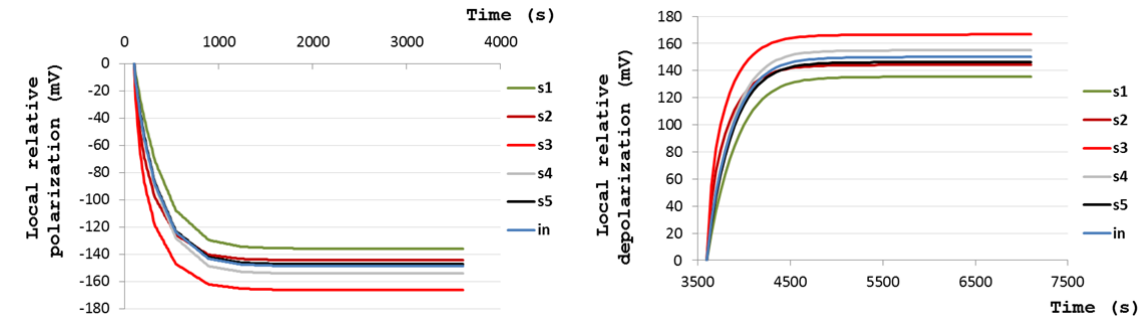
Figure 7. Local relative polarization (left) and depolarization (right) time